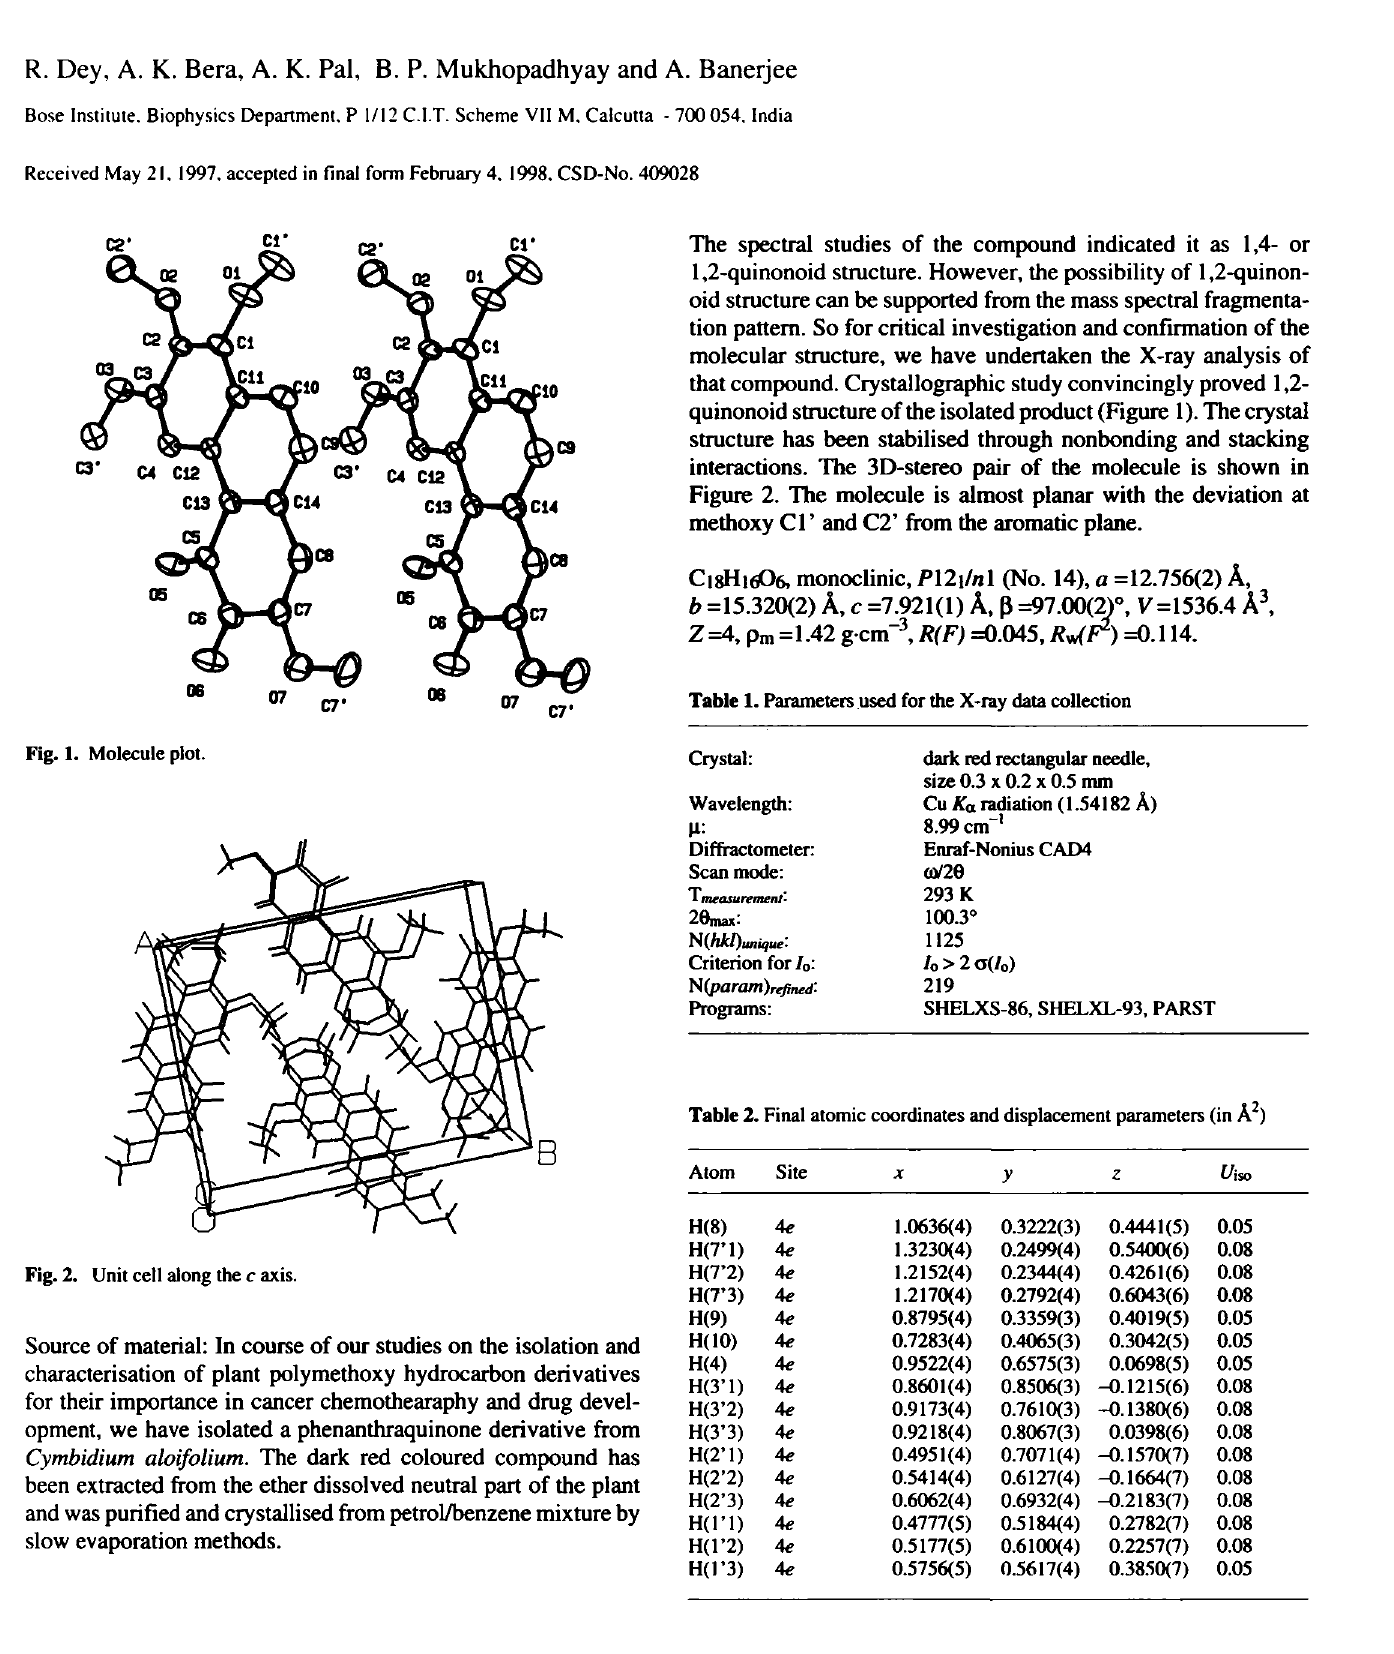
Fig. 2. Unit cell along the с axis.